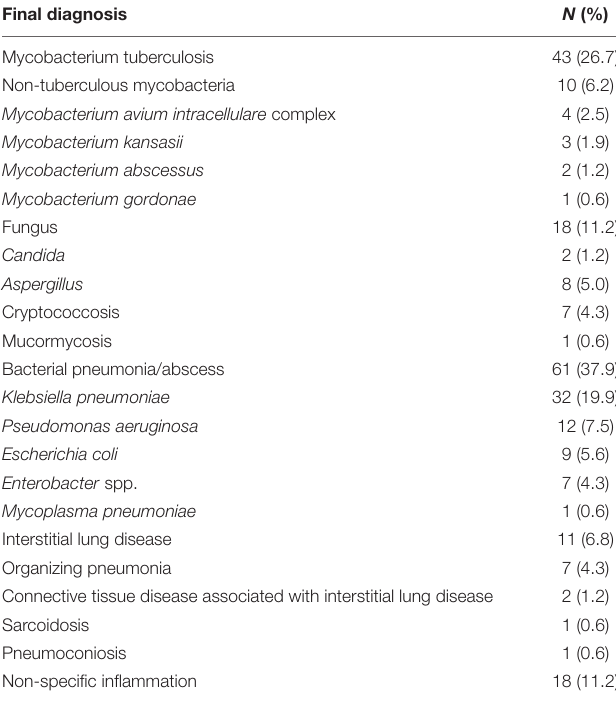
TABLE 2 | Final diagnosis of the 161 patients.